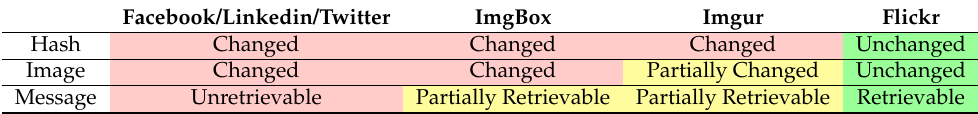
Table 5. Online service